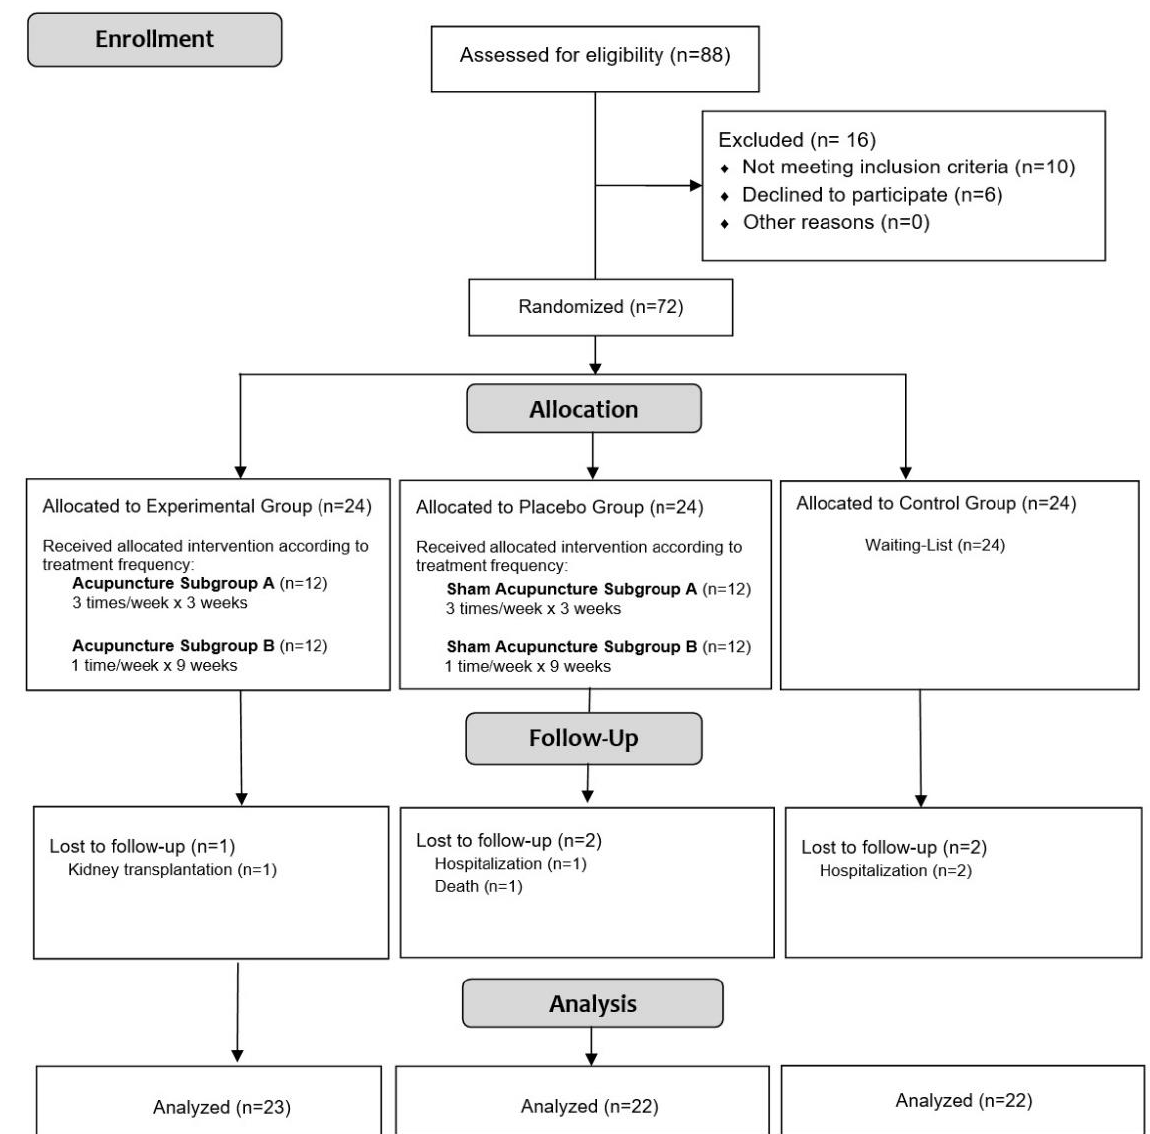
Figure 1. Study flow diagram. The sample included 67 hemodialysis patients aged between 56 and 91, with a mean age of 71.6 (SD = 7.7). Most were men (61.2%), lived in rural areas (64.2%), were retired (85.1%), and had low education levels (73.1% with the 1 ◦ Cycle and 7.5% without any education level). No statistical differences were found between the groups in any of these variables ( p > 0.05). As for the clinical characteristics, the most prevalent cause of CKD was diabetes mellitus (43.3%). Most of the patients were undergoing HD treatment for over a year and less than 10 years (83.6%) and used arteriovenous fistula (91.0%). No